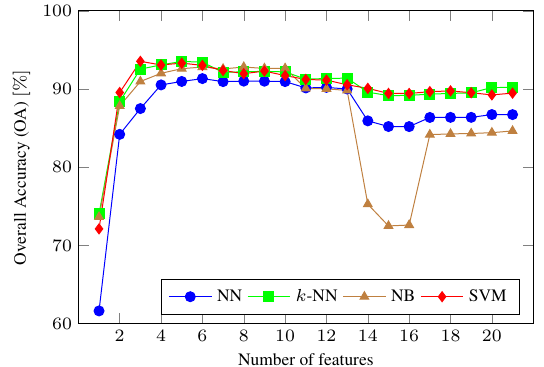
Figure 2: Overall classification accuracies for different classi- fiers: The size of the feature subset is iteratively increased ac- cording to the ascending global rank depicted in Figure 1.